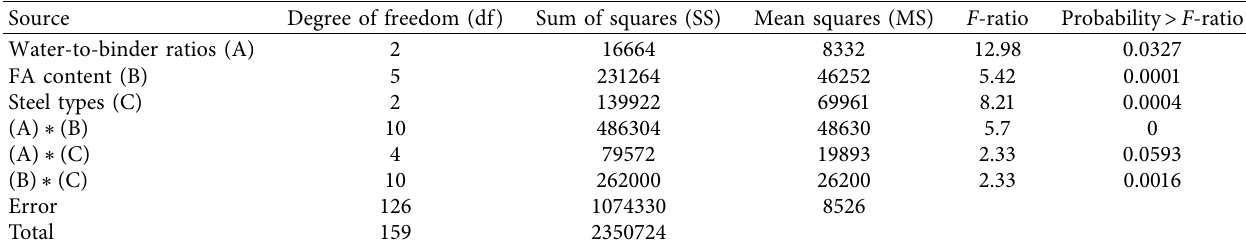
Table 6: ANOVA result for active to passive potential for uncarbonated concrete.